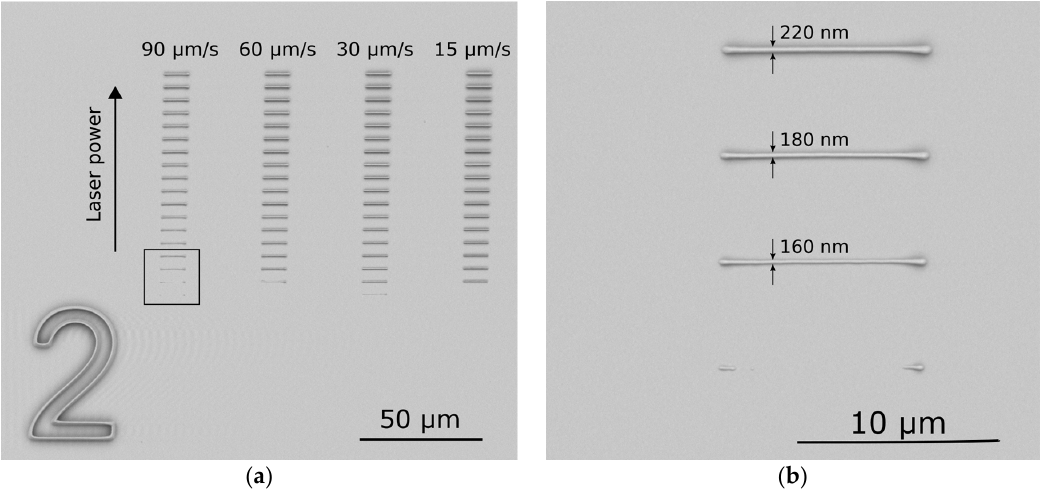
Figure 2. Scanning electron microscope (SEM) image of the writing tests for the threshold power for PR-20 : laser power and writing speed dependence. ( a ) Laser power is varied from less than 1 mW up to 10 mW, adding 0.44 mW from one segment to the next with each increase in the y -position; ( b ) Detail of the threshold lines, zoom of the square in the ( a ) image.